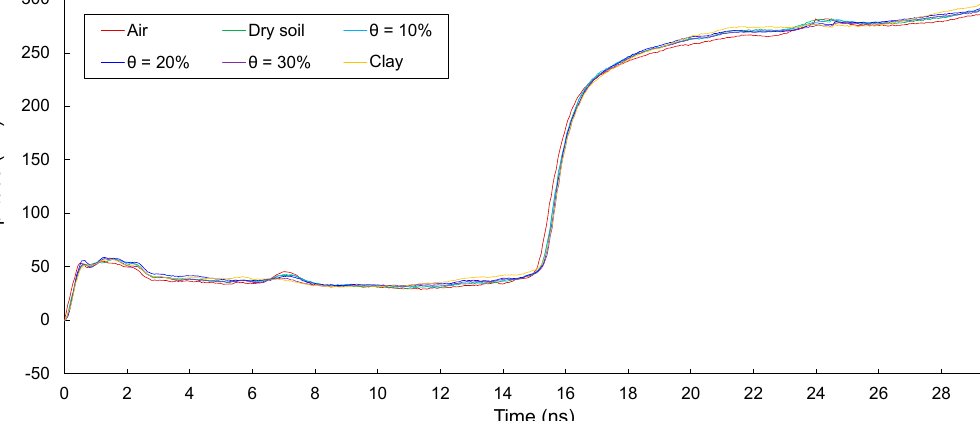
Figure 12. Measured signals for D5 with the defect filled with different materials of air; dry sand; wet sands with θ = 10%, 20%, and 30%; and clay. Table 3. Travel time of electromagnetic waves reflected from defects ( Δ t 1 ), amplitude difference between the peak and minimum ( Δ V ), and sensitivity of signals reflected at the defects.